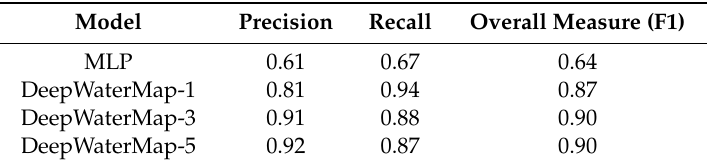
Table 4. Comparison of models between the conventional MLP and DEEPWATERMAP with one, three and five convolutional blocks [92].